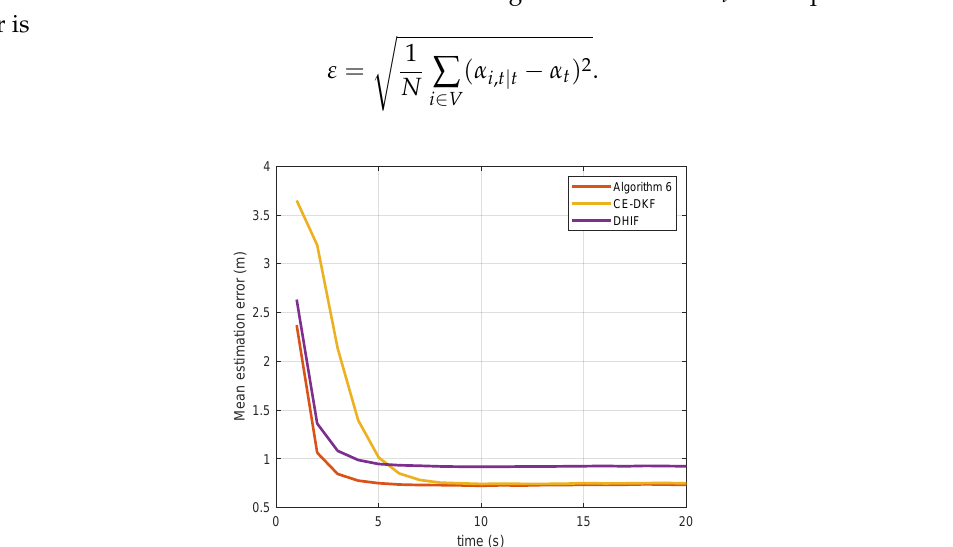
Figure 2. Mean estimation errors of different estimation algorithms ( Q = Q 1 ). CE-DKF: cost-effective diffusion Kalman filter; DHIF: distributed hybrid information